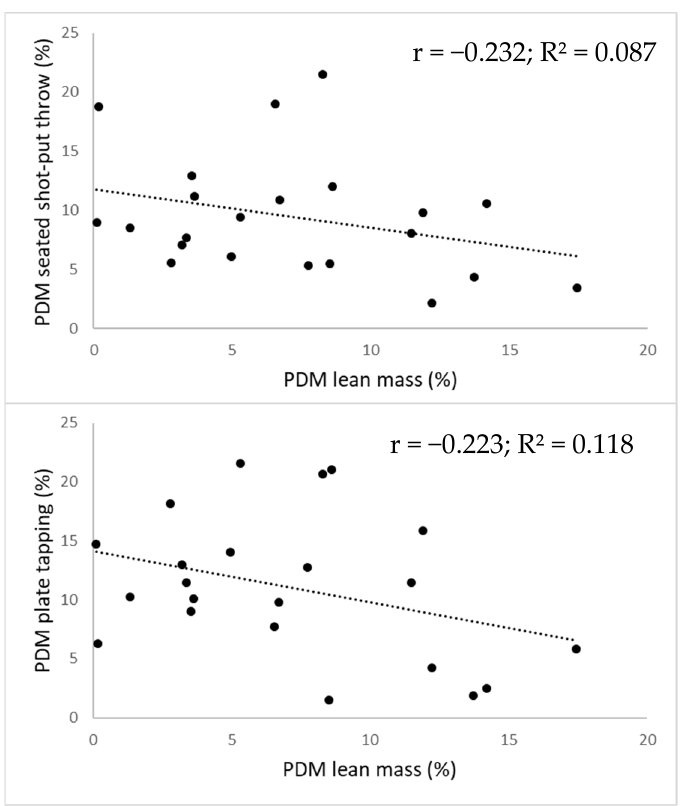
Figure 1. Scatter plot illustrating the relationship between the magnitude of upper extremity lean mass asymmetry (x-axis) and the magnitude of upper extremity functional asymmetry (y-axis) for the high-level female tennis players (N = 22). Note: The dotted line represents the linear trend line; PDM = percentage difference method; r = correlation coefficient; R² = R squared value.